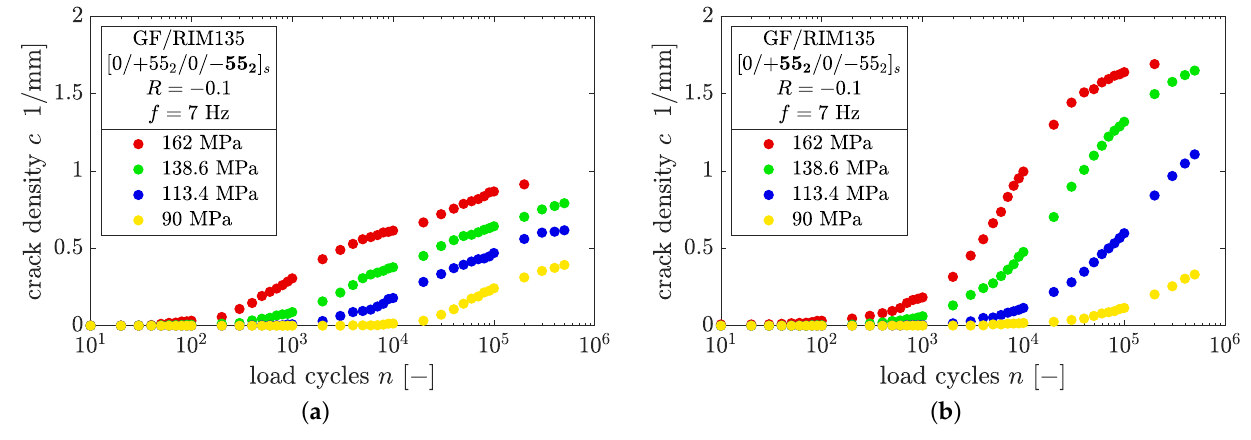
Figure A7. Results of the crack counting procedure for [ 0/ + 55 2 /0/ − 55 2 ] s -laminates for ( a ) thick and ( b ) thin layers at R = −